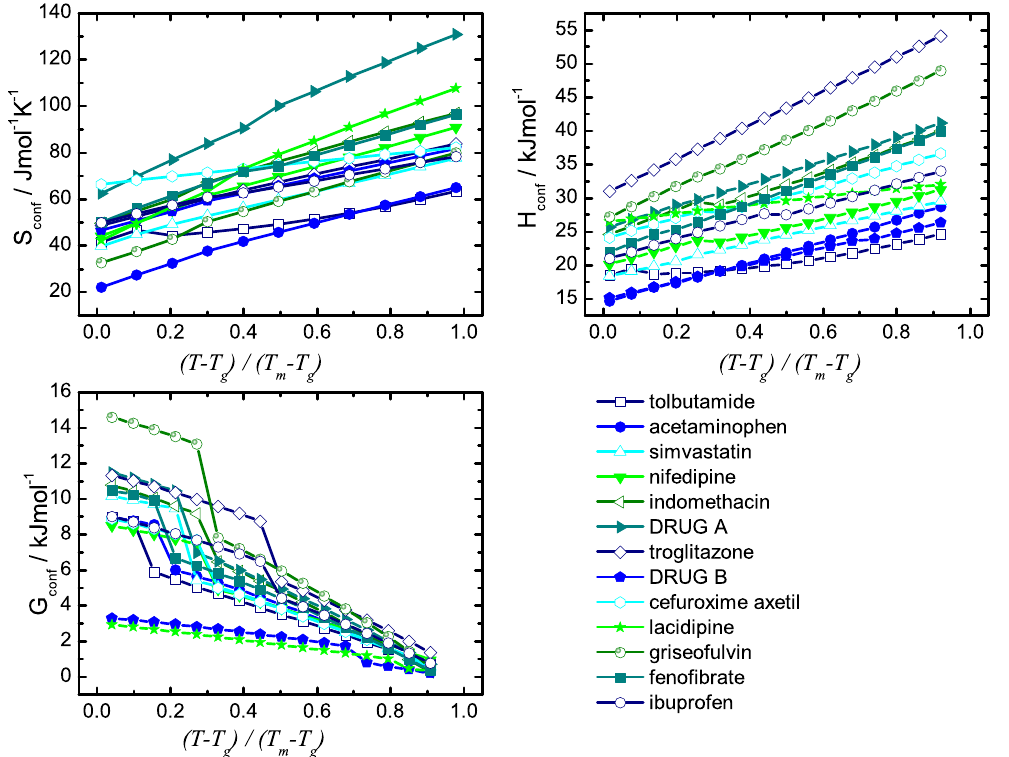
Figure 5. Temperature dependence of the configurational thermodynamic properties.